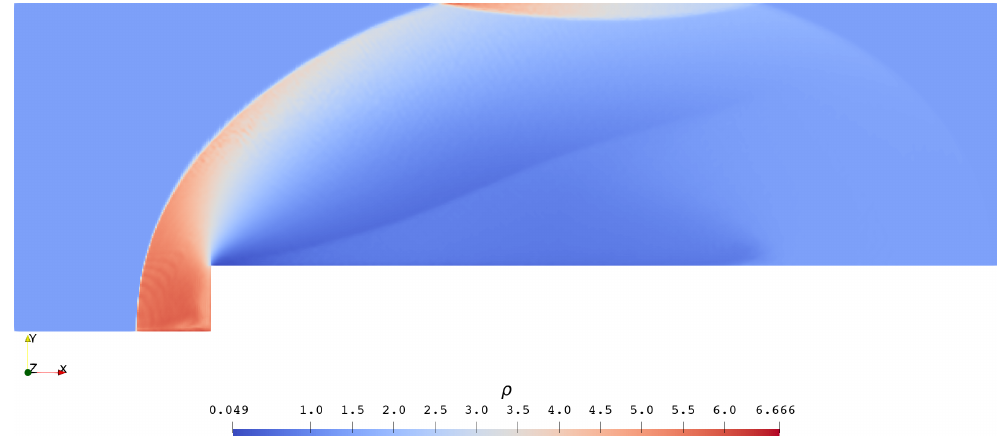
Figure 11. Third-order solution of Problem 4 at t = 0.6 on an h = 1/200